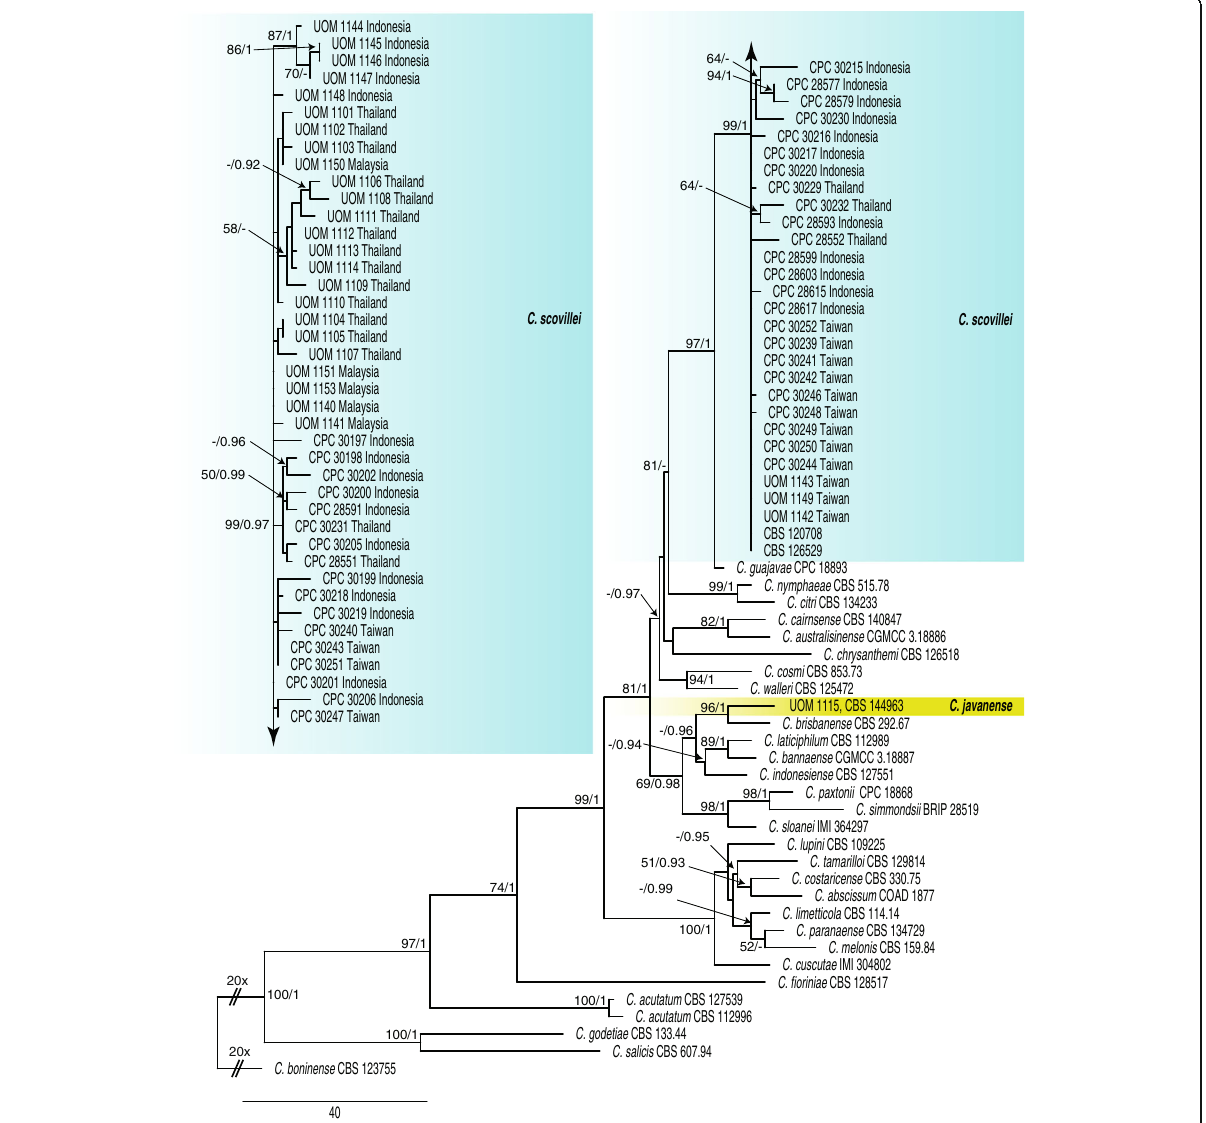
Fig. 1 First of 1000 equally most parsimonious trees obtained from a heuristic search of the combined ITS , tub2, gapdh, chs-1, his3 and act sequence alignment of the Colletotrichum isolates in the acutatum complex. The parsimony bootstrap support values (MP > 49%) and Bayesian posterior probabilities (PP > 0.90) are displayed at the nodes (MP/PP). The tree was rooted to C. boninense (CBS 123755). The bar indicates 40 changes. Coloured blocks are used to indicate clades containing isolates from